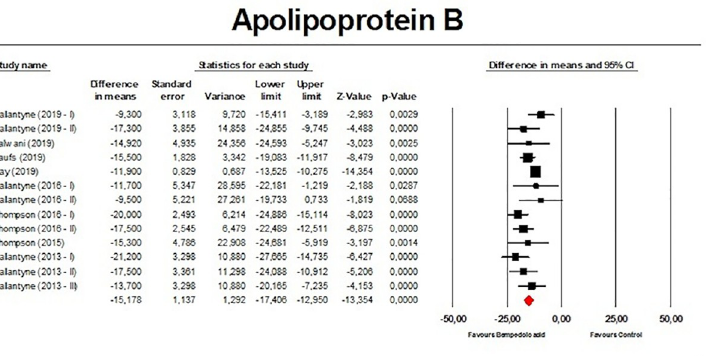
Fig 6. Forest plot displaying mean difference and 95% confidence intervals for the effect of bempedoic acid on plasma levels of apolipoprotein B.